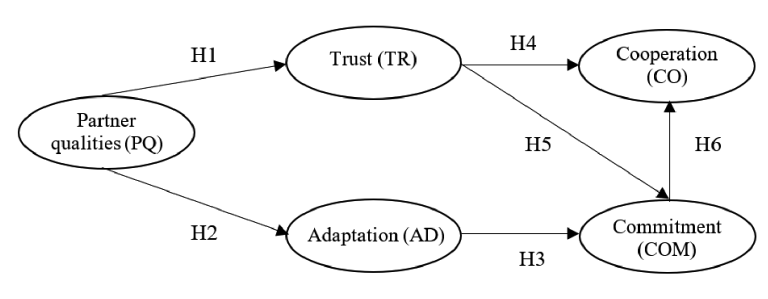
Figure 1. Hypothetical